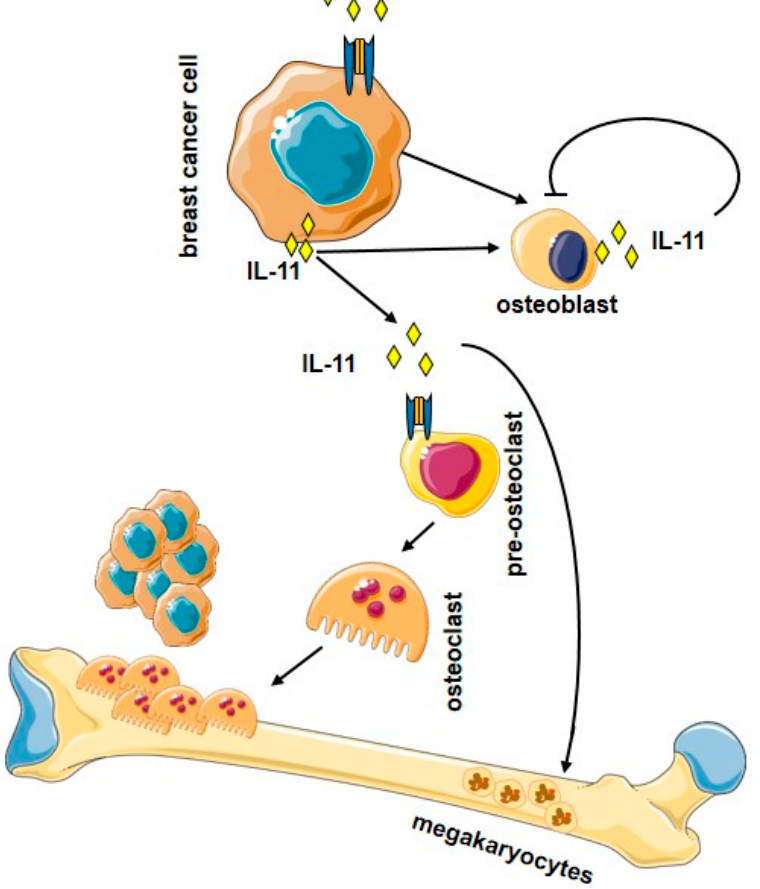
Figure 3. Overview of the osteolytic effects of IL-11 in bone metastasis. IL-11 released from breast cancer cells targets osteoblasts and osteoclasts. (Figure created using Servier Medical Art available at https://smart.servier.com, accessed on 7 May